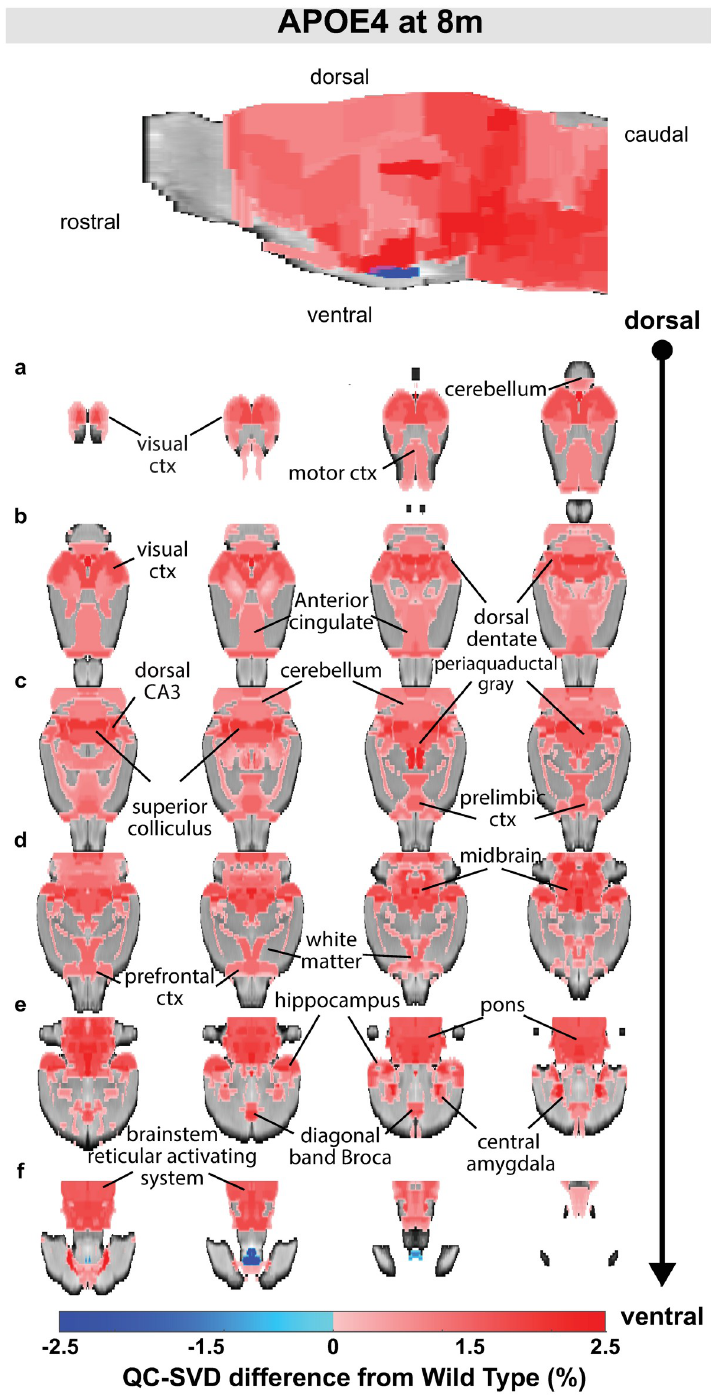
Fig 2. Overview of QC-SVD abnormality detected in APOE4 animals ( q < .05). Measurements were collected at 8 months. When significant, the differences from WT are reflected in the color scale (hyper-vascularized = red, hypo- vascularized = blue). The brain volume affected was 48.3% hyper-vascularized and < 0.1% hypo-vascularized. Sagittal maximum intensity projections are displayed on top. Rows labeled (a-f) are coronal brain slices progressing dorsal to ventral with left-to-right ordering. Regions are labeled. An anatomical atlas with 174 regions was used for region-of- interest selection.